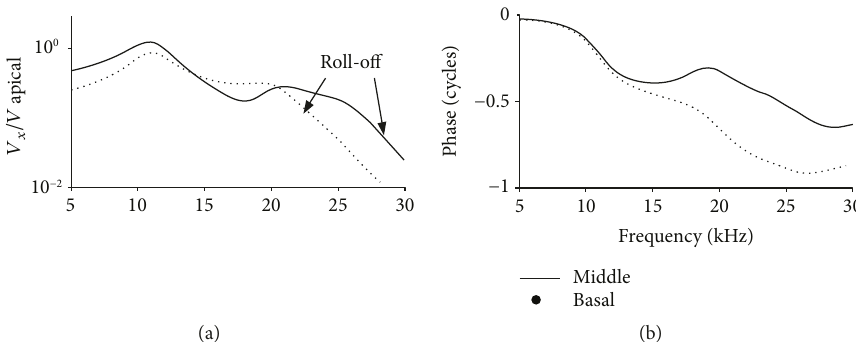
Figure 6: BM vibration responses of a mathematical model of the cochlea under backward driving. (a) Amplitude responses of BM vibration at two longitudinal locations. Solid line, labeled as middle, is at a more apical location; dotted line, labeled as basal, is at a more basal location. The arrows marked the roll-o ff points. (b) Phase